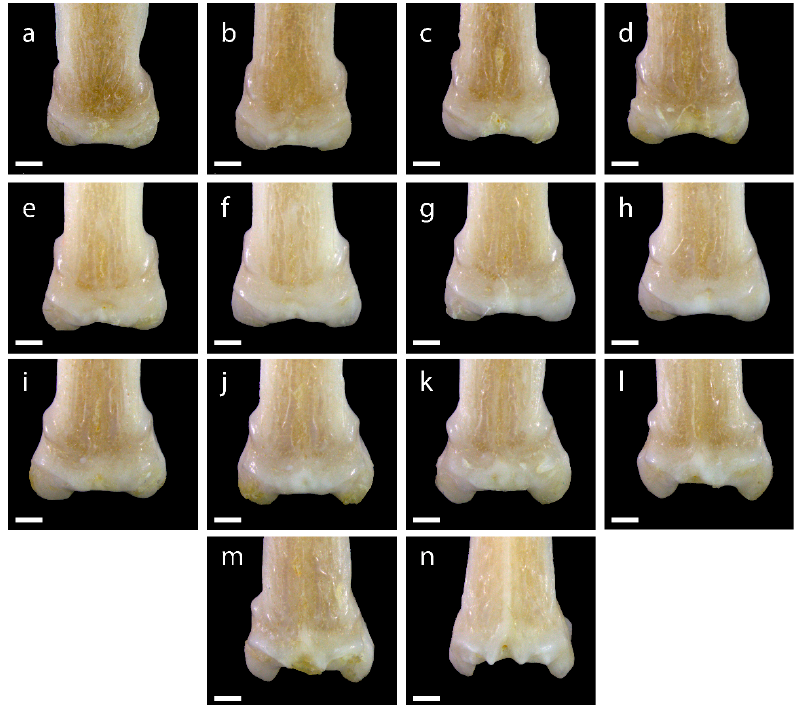
Figure A8. Microscopic images of the anterior view of the pinnules of P. bichir PO3. The images ( a – n ) correspond to the 1st, 2nd, 3rd, 4th, 5th, 6th, 7th, 8th, 9th, 10th, 11th, 12th, 13th, and 14th pinnules, respectively. Scale bars = 1 mm.